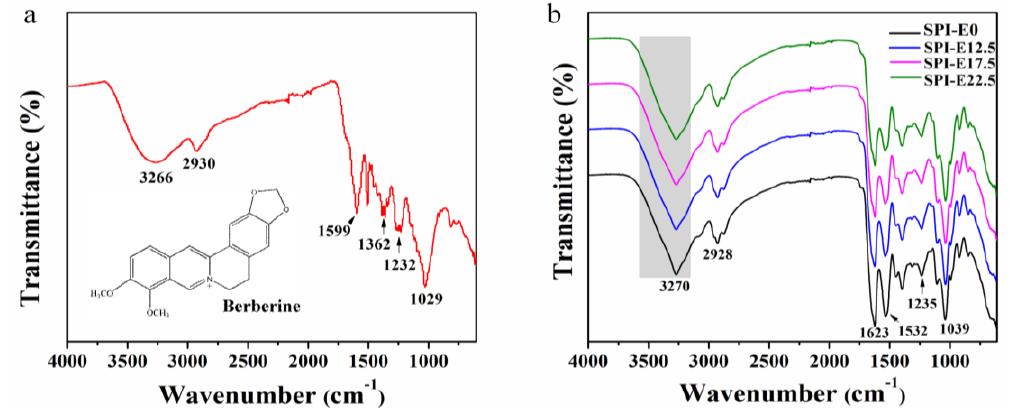
Figure 1. Fourier transform infrared spectroscopy (FTIR) spectra of ( a ) cortex Phellodendron extract (CPE) and ( b ) soybean protein isolate (SPI)-based films.